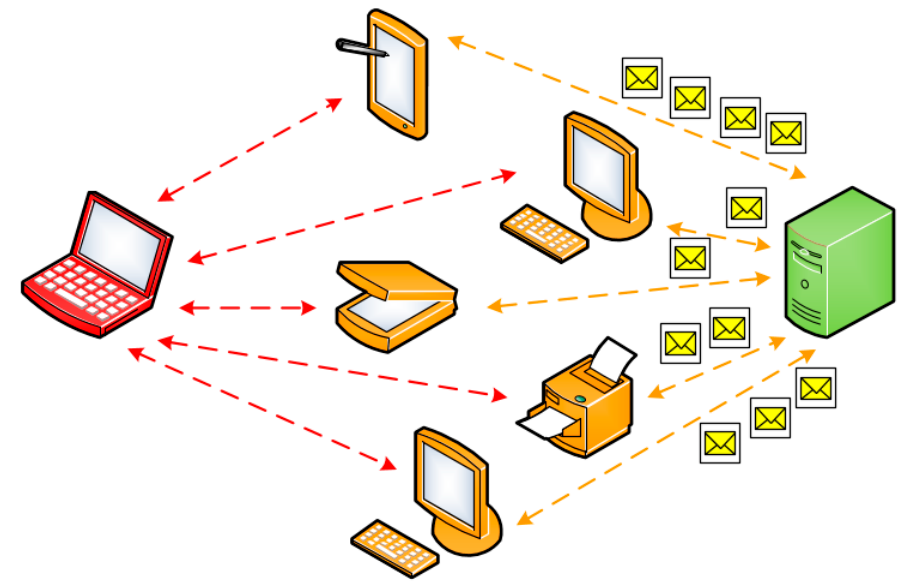
Figure 4. A DDoS attack case.